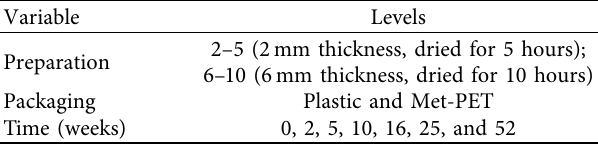
Table 1: Controlled variables of this storage study. Variable Levels